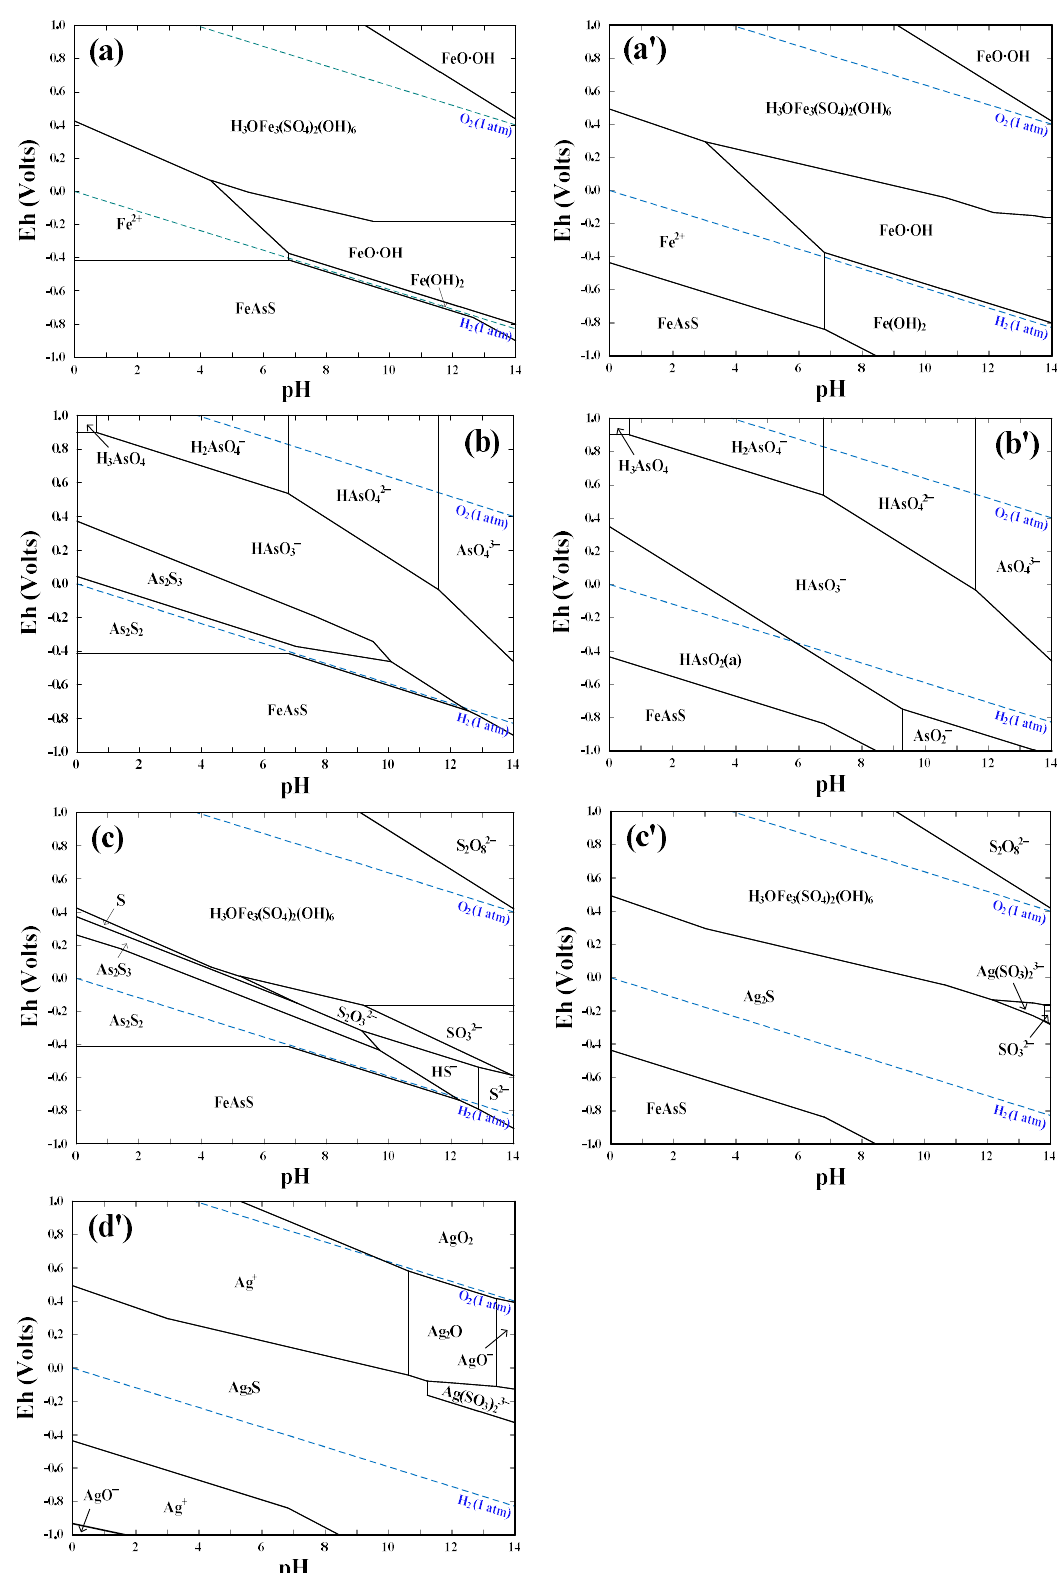
Figure 2. Eh  pH diagrams of ( a )–( c ) FeAsS  H 2 O system and ( a' )–( d' ) FeAsS  Ag +  H 2 O system for Figure 2. Eh − pH diagrams of ( a )–( c ) FeAsS − H 2 O system and ( a' )–( d' ) FeAsS − Ag + − H 2 O system for ( a )/( a' ) Fe species, ( b )/( b' ) As species, ( c )/( c' ) S species and ( d' ) Ag species. Conditions: [Fe 2+ ] 0.16 M, ( a ) / ( a' ) Fe species, ( b ) / ( b' ) As species, ( c ) / ( c' ) S species and ( d' ) Ag species. Conditions: [Fe 2 + ] 0.16 M, [FeAsS] 0.06 M, [Ag + ] 0.046 mM; 25 °C and 1 atm. [FeAsS] 0.06 M, [Ag + ] 0.046 mM; 25 ◦ C and 1